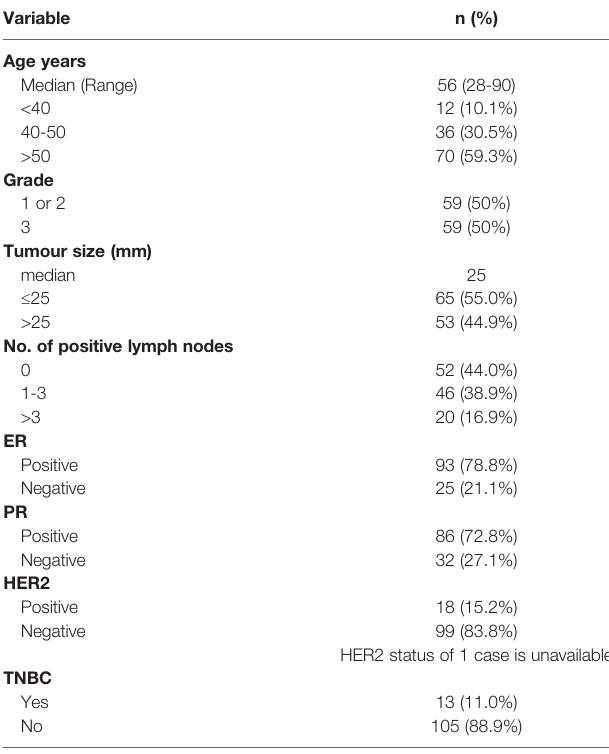
TABLE 2 | Clinical characteristics of 118 (TNBC and non-TNBC) samples of the second cohort. Variable n